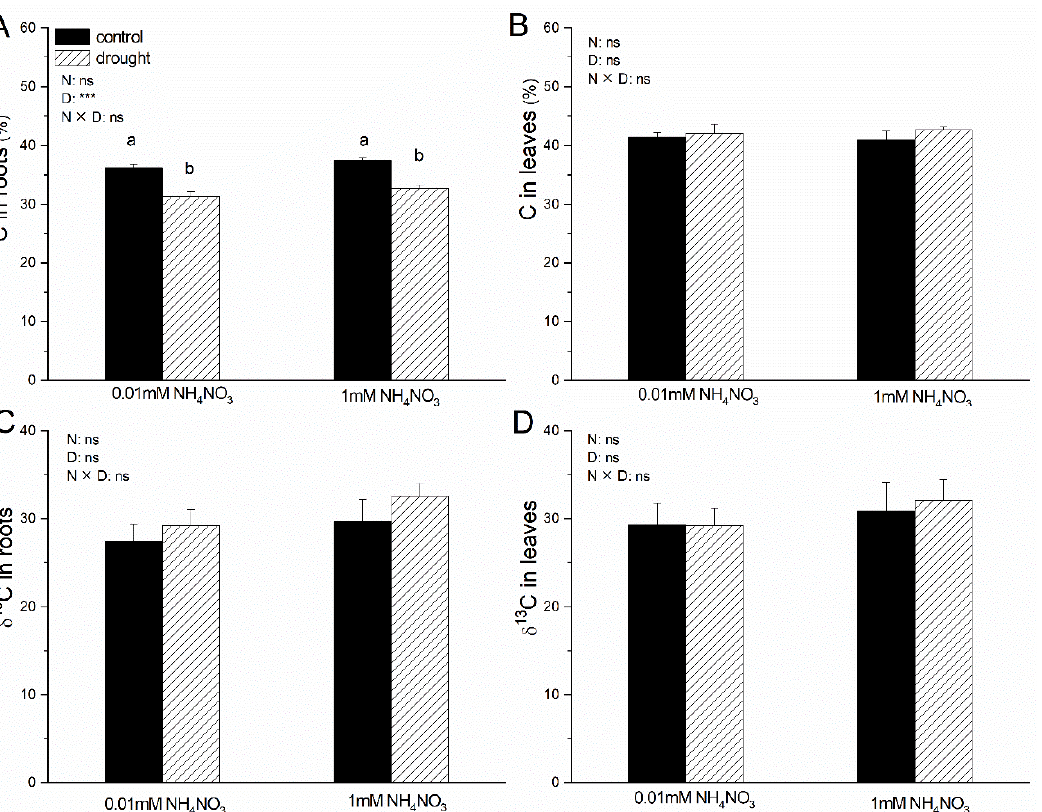
Figure 3. Total C concentration and δ 13 C in roots ( A , C ) and leaves ( B , D ) of Populus simonii as affected by nitrogen supply and drought stress. Data indicate mean ± SE ( n = 6). Different letters in the same column indicate significant differences. N, N supply; D, drought treatment; N × D, interaction of N supply and drought treatment. *, p < 0.05; **, p < 0.01; ***, p < 0.001; ns, not significant.